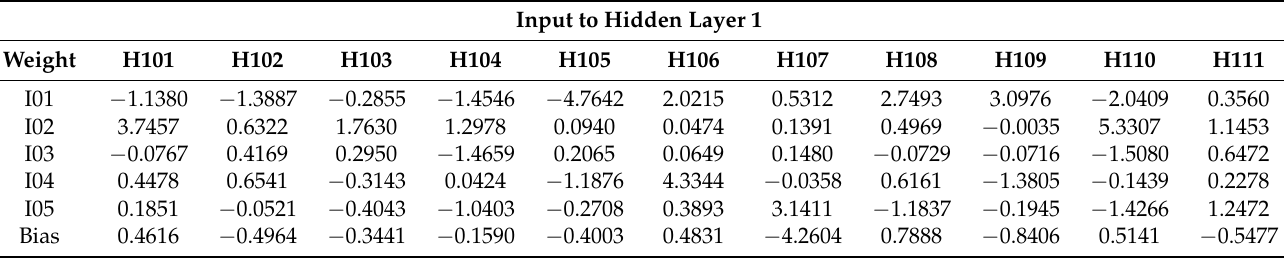
Figure 19. Optimized hyperparameters and network structure for the circular plate (CAE-1024). Table 26. Weight and bias between the input layer and the first hidden layer